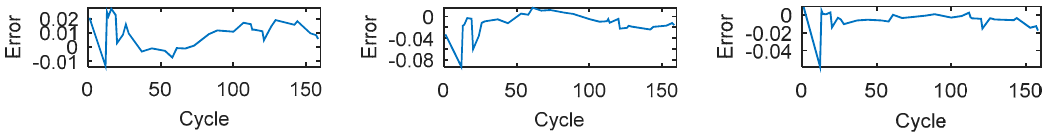
Figure 6. The SOH estimation results of the LS-SVM model with the linear kernel tested on the No.5, No.6 and the No.7 batteries.